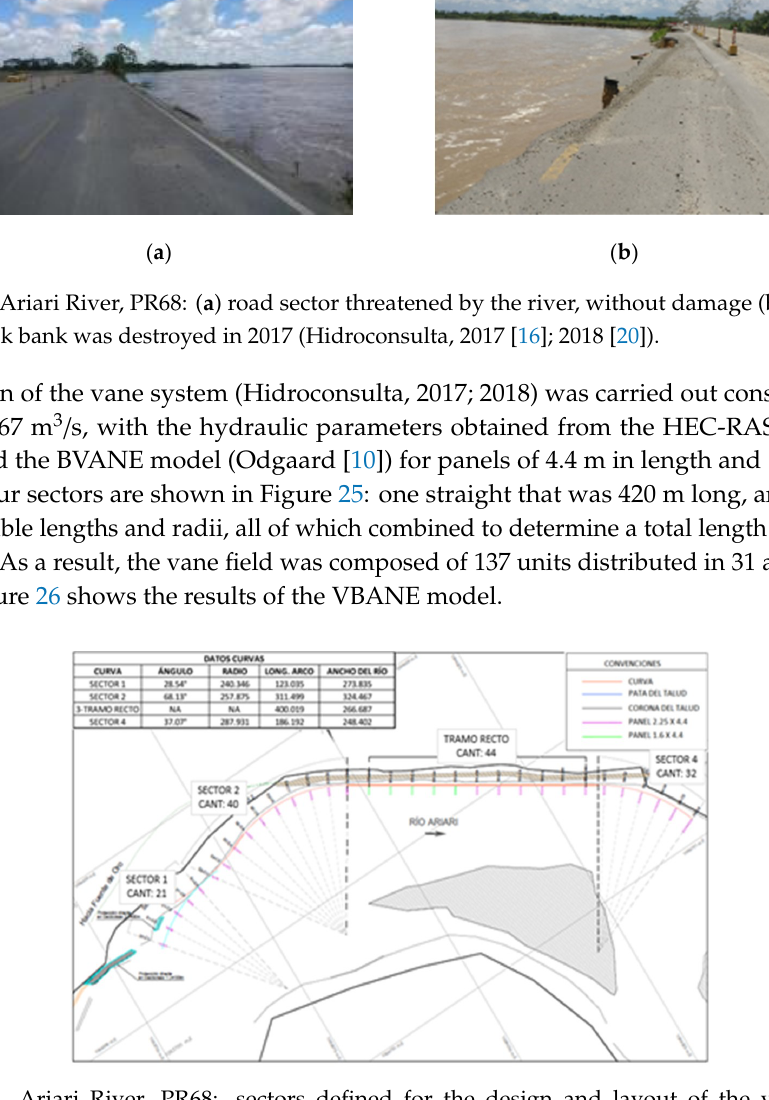
Figure 25. Ariari River, PR68: sectors defined for the design and layout of the vane system (Hidroconsulta [16]). Table 3. Ariari River, PR68: optimal design of the initial version of the vane system.